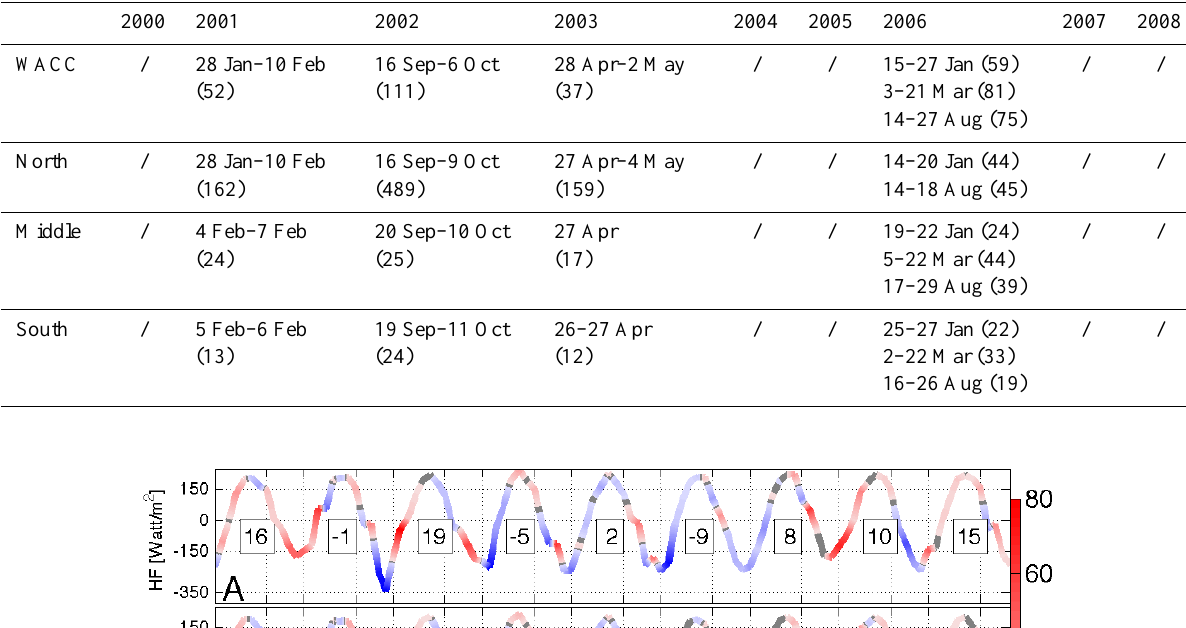
Table 1. Number and time intervals of CTD sampling for each year.